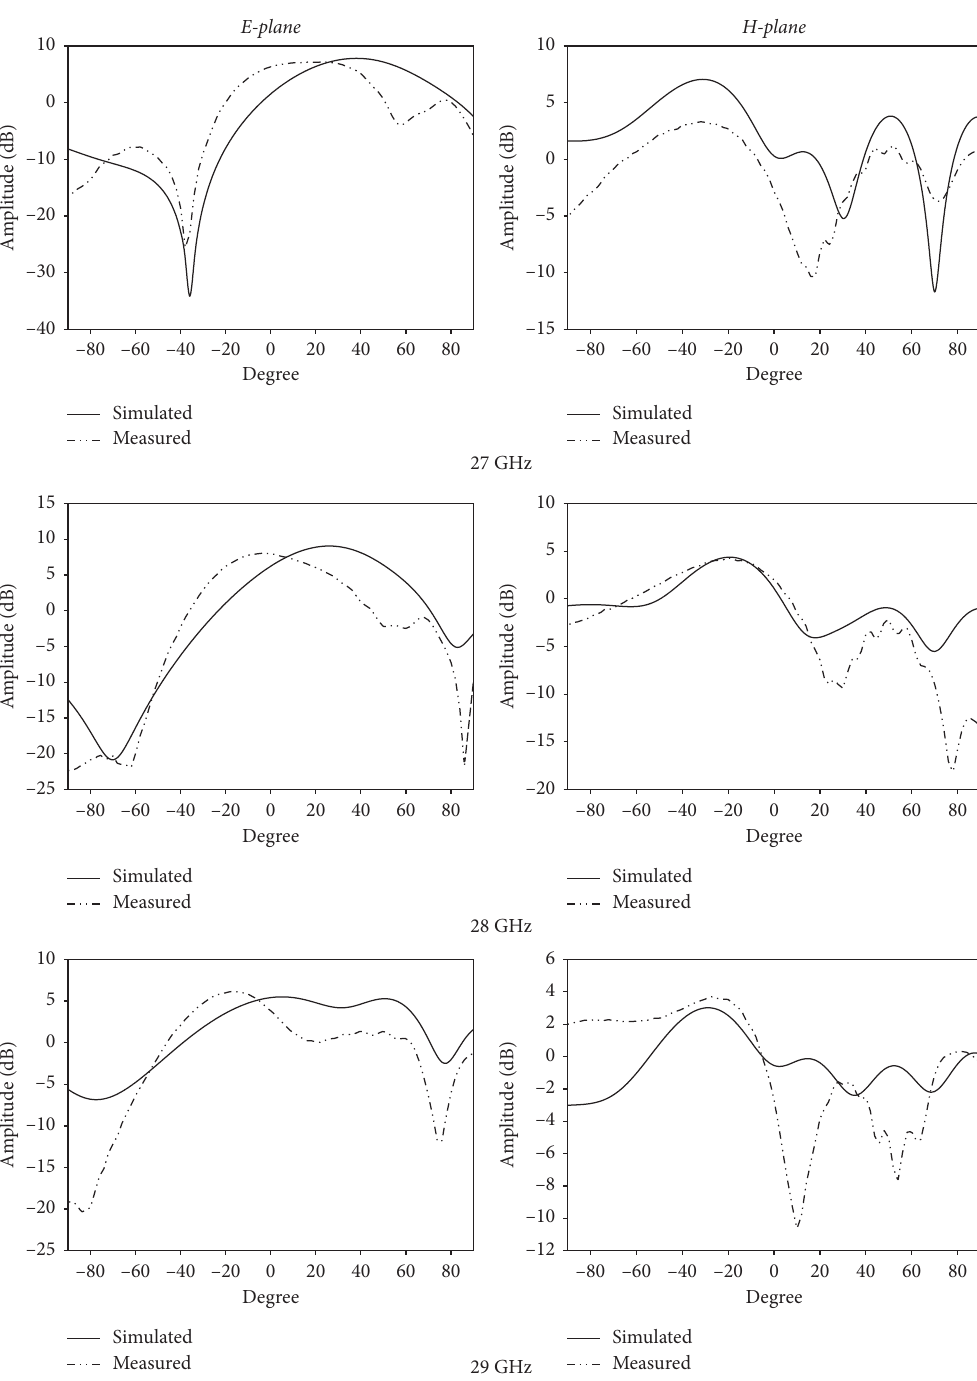
Figure 14: Radiation patterns of the proposed corporate-series-fed array antenna at 27GHz, 28GHz, and 29 GHz.